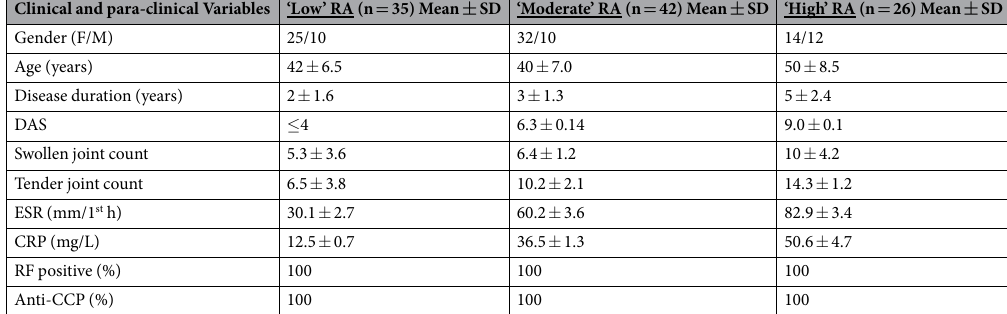
Table 1. Characteristics of 103 patients with rheumatoid arthritis included in the study. DAS: disease activity score, ESR: erythrocyte sedimentation rate, CRP: C-reactive protein, RF: rheumatoid factor, CCP: cyclic citrullinated peptide.